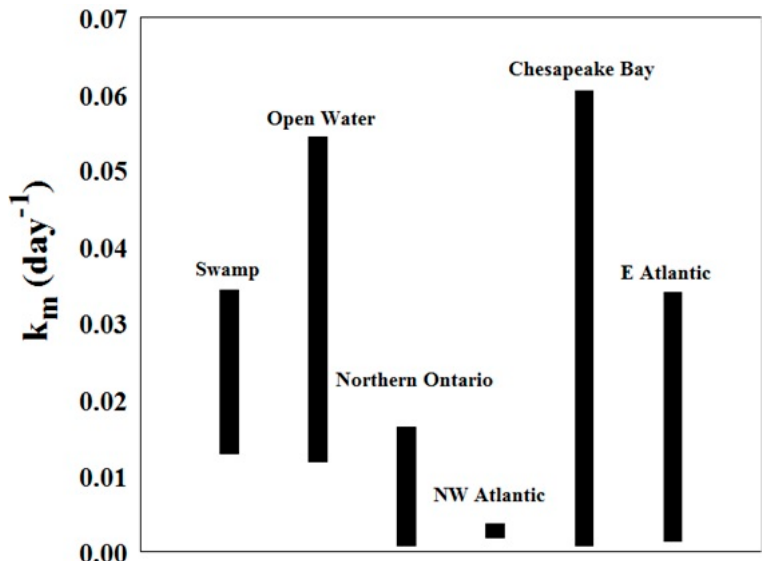
Figure 10. Methylation rates from this study (bars labelled swamp and open water) compared to literature values at sites along the Atlantic Coast and in northern Ontario [1,36,37].